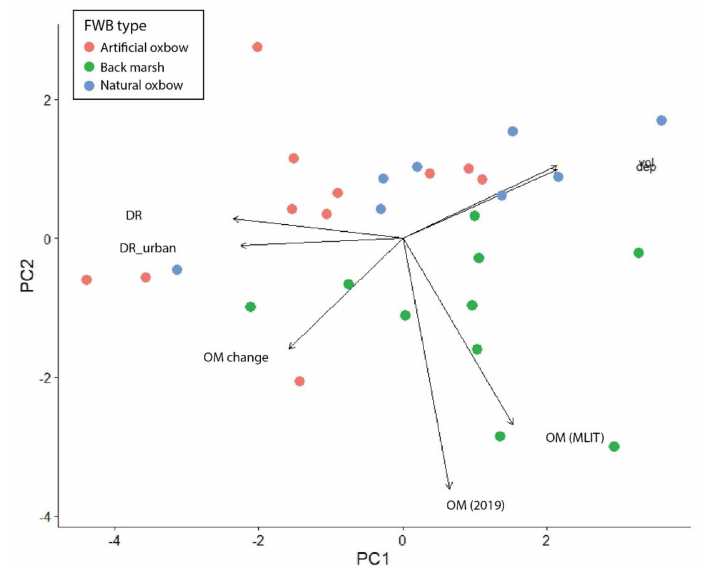
Figure 7. The correlations between temporal and spatial patterns in organic matter contents of sediment and their controlling variables. Three different types of floodplain water body are also shown. Out of the overall variation of organic matter content, 55% is displayed on the horizontal axis (PC1) and another 22% of the vertical